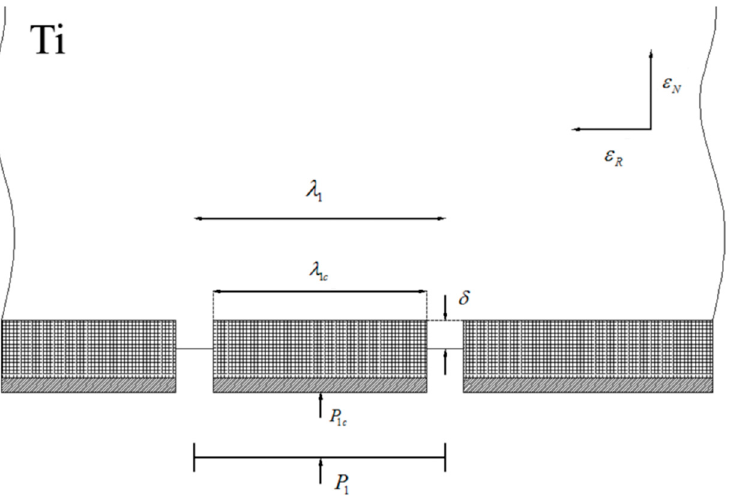
Figure 29. Model of metal extrusion through the crack of WHL on the surface of the titanium layer in type I.